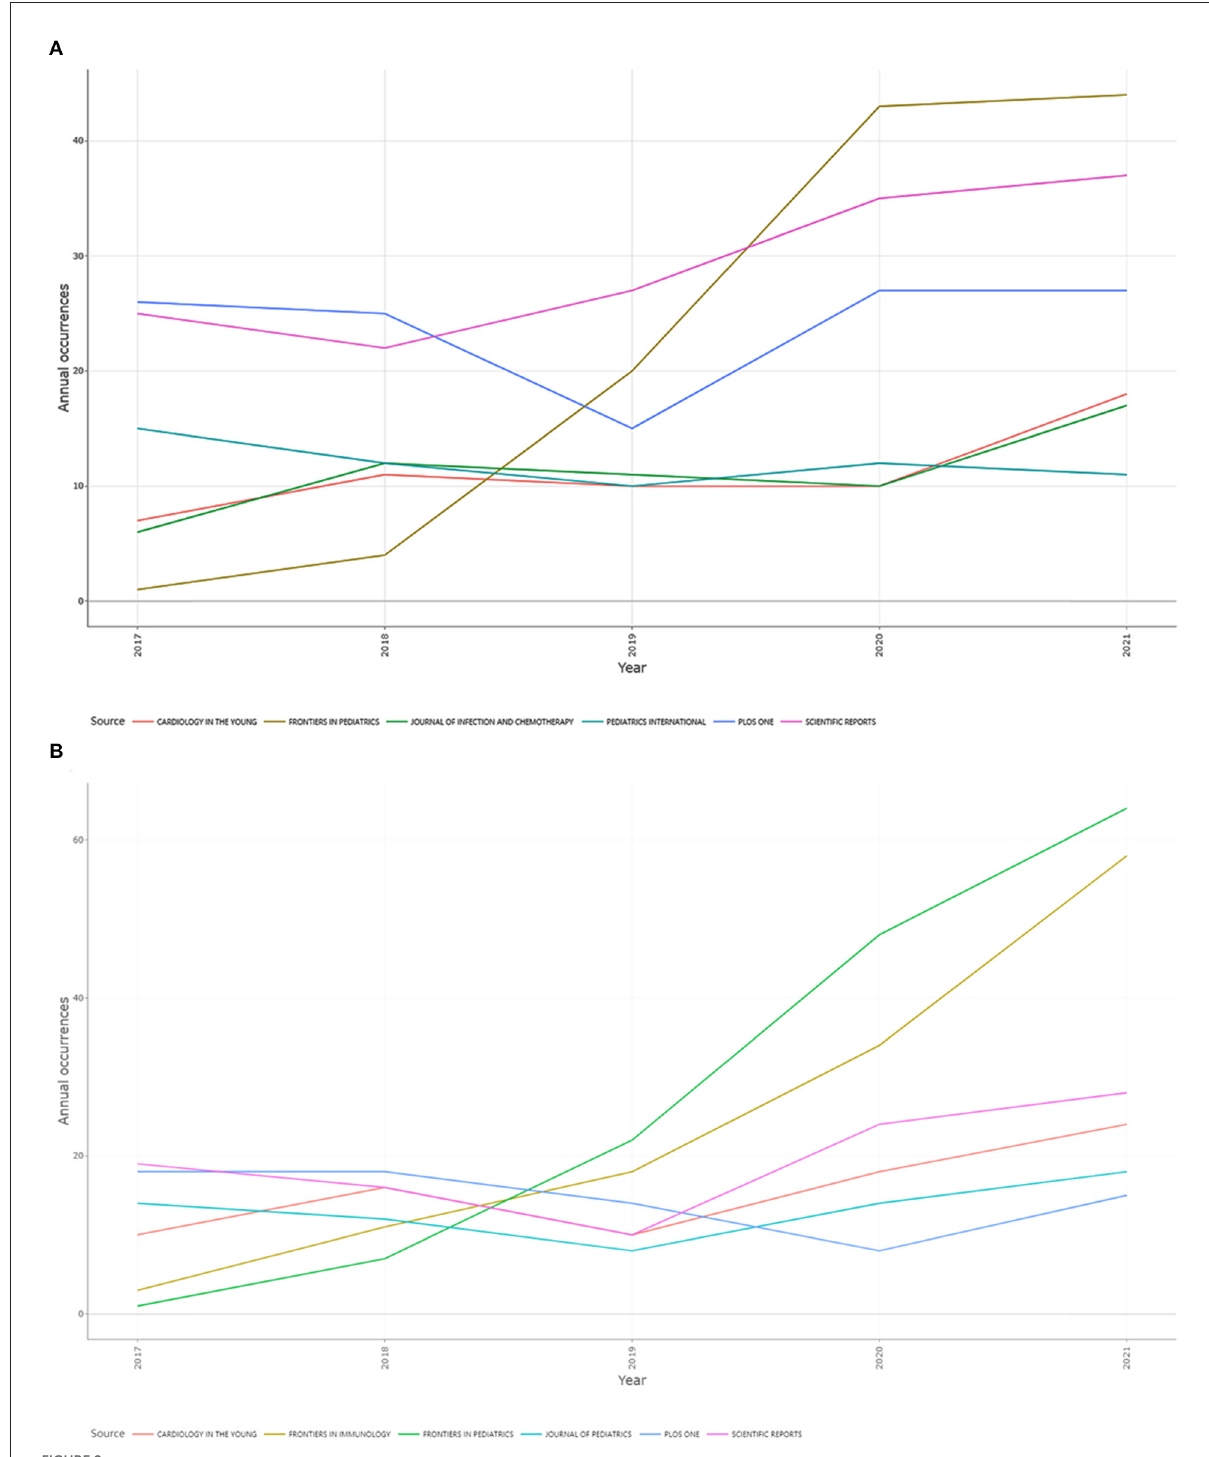
FIGURE2 A line chart showing the annual trend of documents published in the top six journals of KD research (2017–2021): (A) WOS and (B) Scopus. The abscissa represents different years, the ordinate represents the number of documents published each year, and different color curves represent different